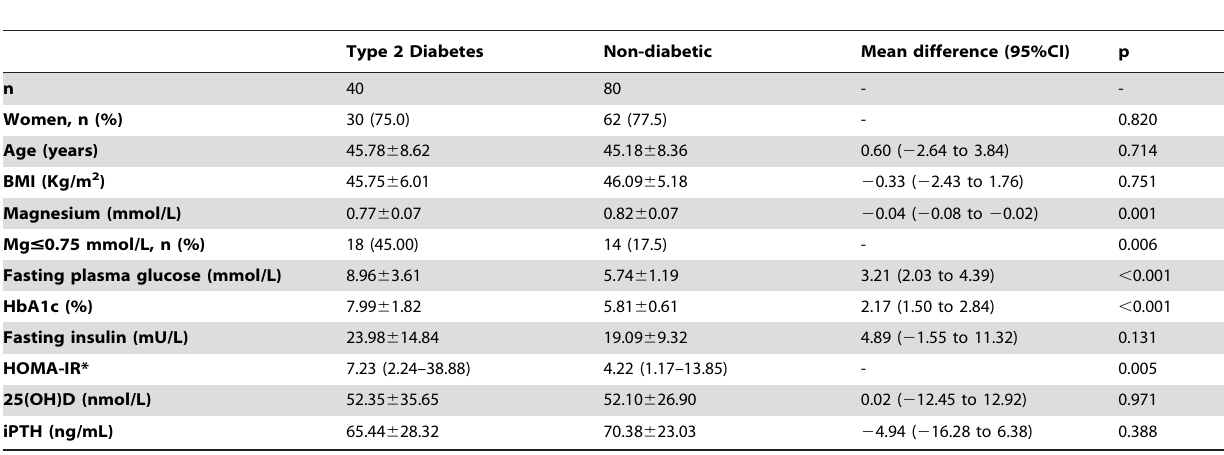
Table 2. The main clinical features and laboratory data of the study population underwent RYGBP according to the presence of type 2 diabetes.